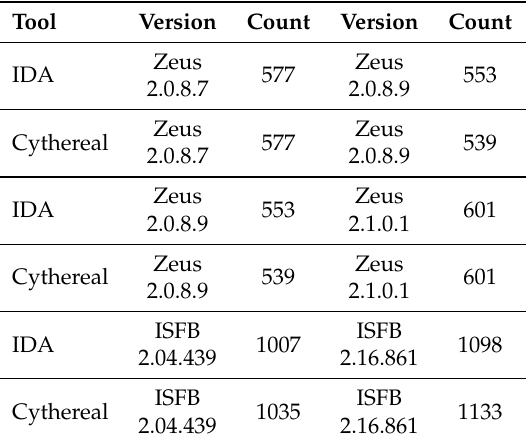
Table 4. Function Counts and Manual Match